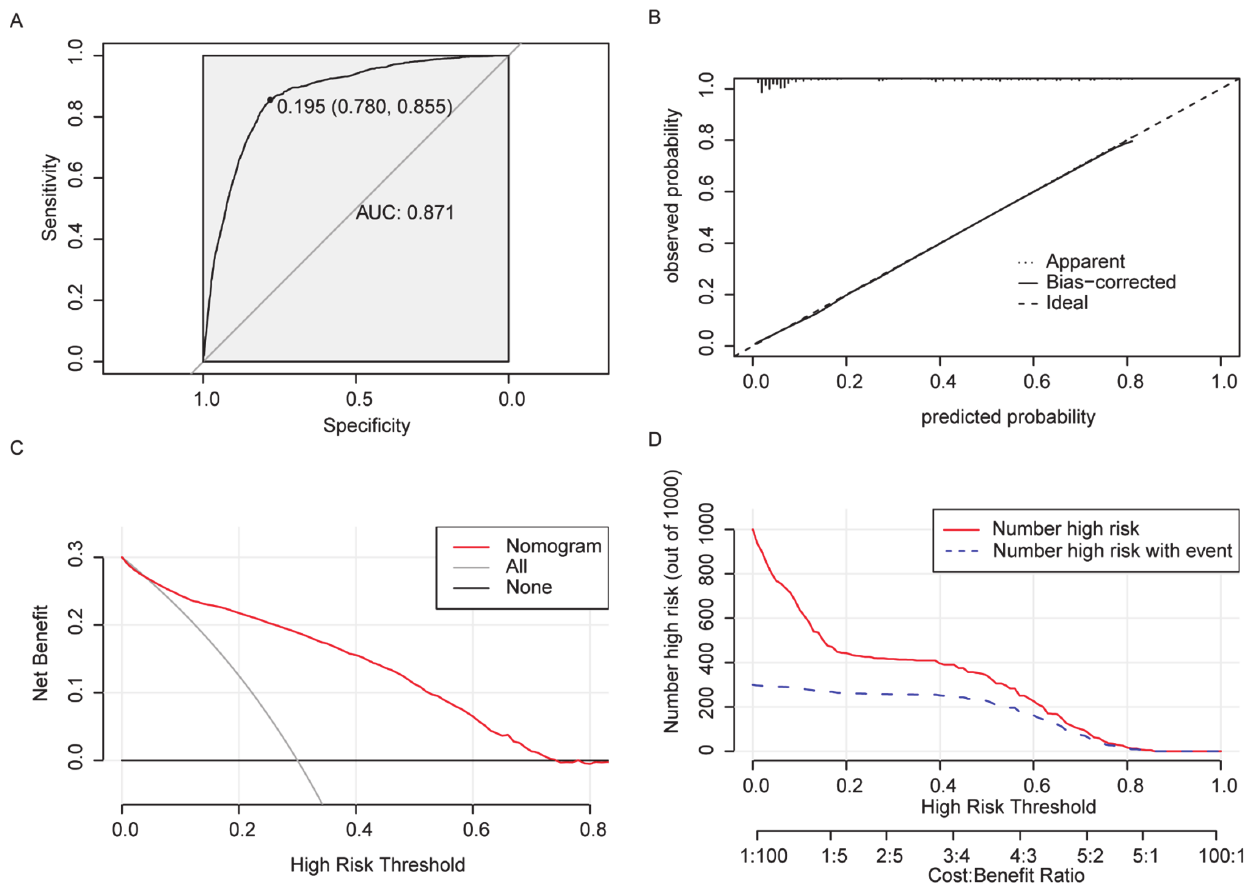
Figure 4. ( A ) Receiver operating characteristic curve. ( B ) Calibration curve. ( C ) Decision curve analysis. ( D ) Clinical influence curve.